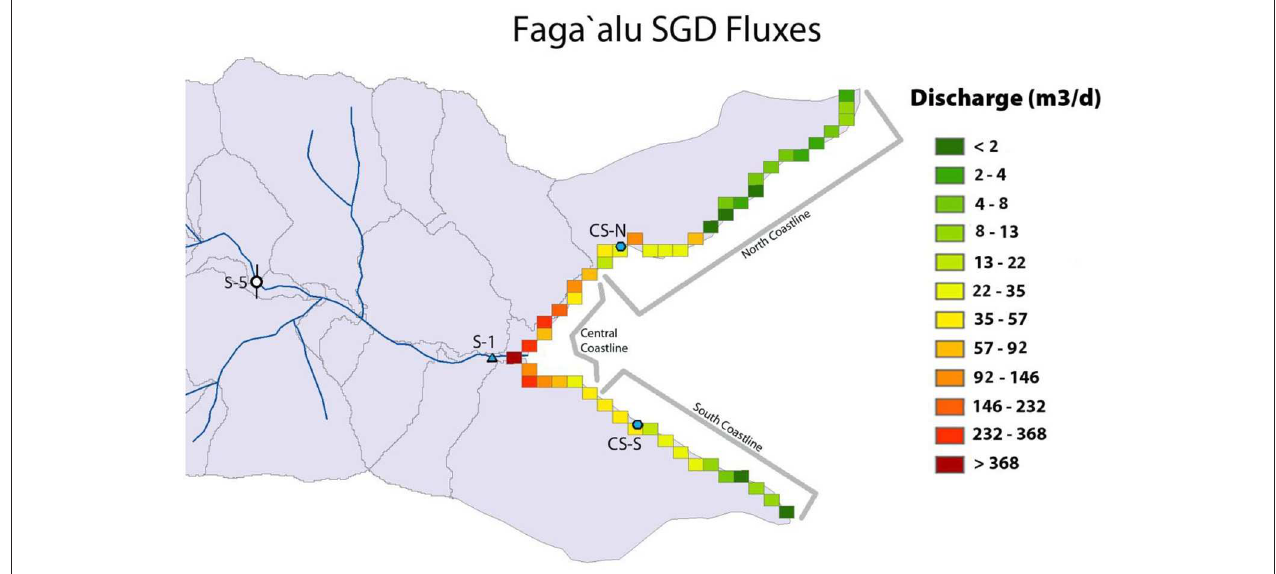
FIGURE 3 | MODFLOW model derived SGD fluxes show larger groundwater discharge to the central portion of the bay, with diminishing fluxes outward toward the northern and southern ends of the bay. Grid cells belonging to the northern, central, and southern sectors of the coastline as well as coastal springs (CS-N, S-1, and CS-S) are